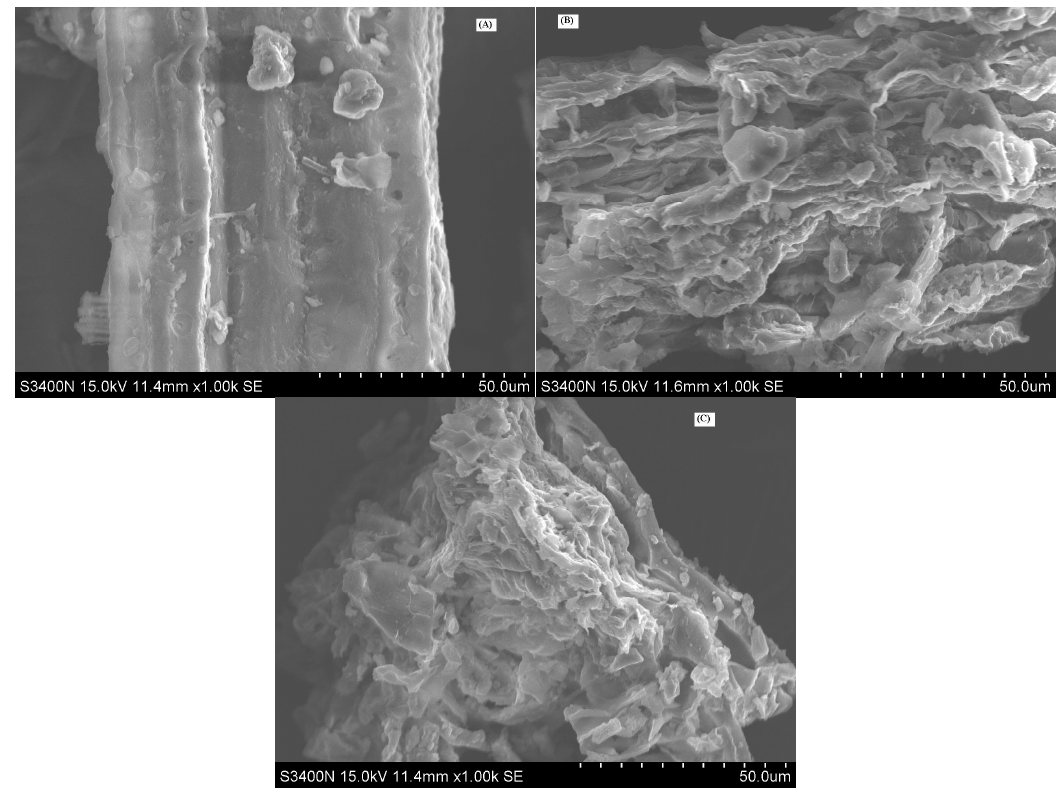
Figure 3. SEM pictures of GBL before ( A ) and after ( B ) EBUE as well as Soxhlet extraction ( C ).